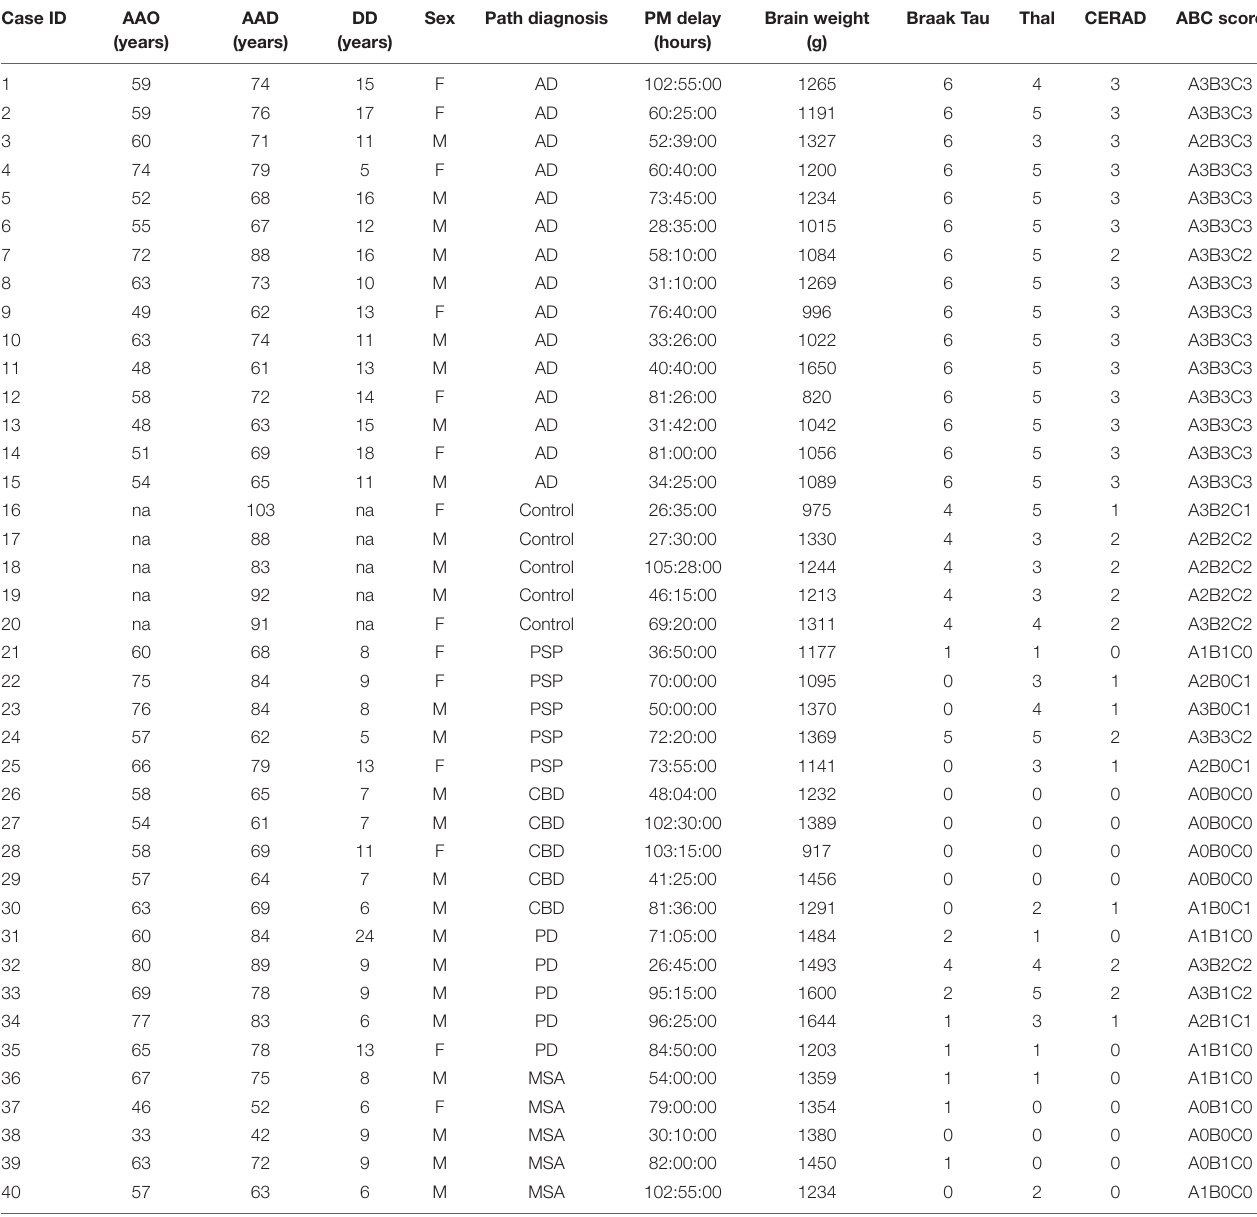
TABLE 1 | Summarized case demographic data for the post-mortem cases used in the